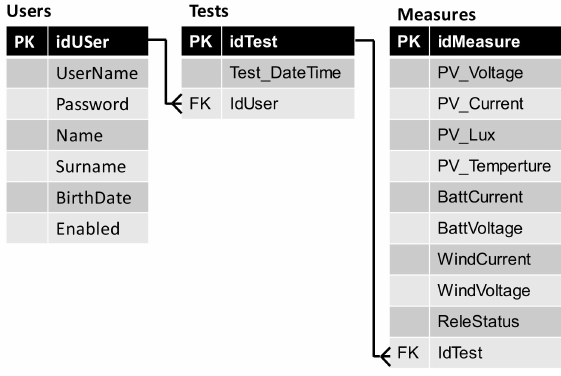
Figure 4. E-R diagram of the demonstrator